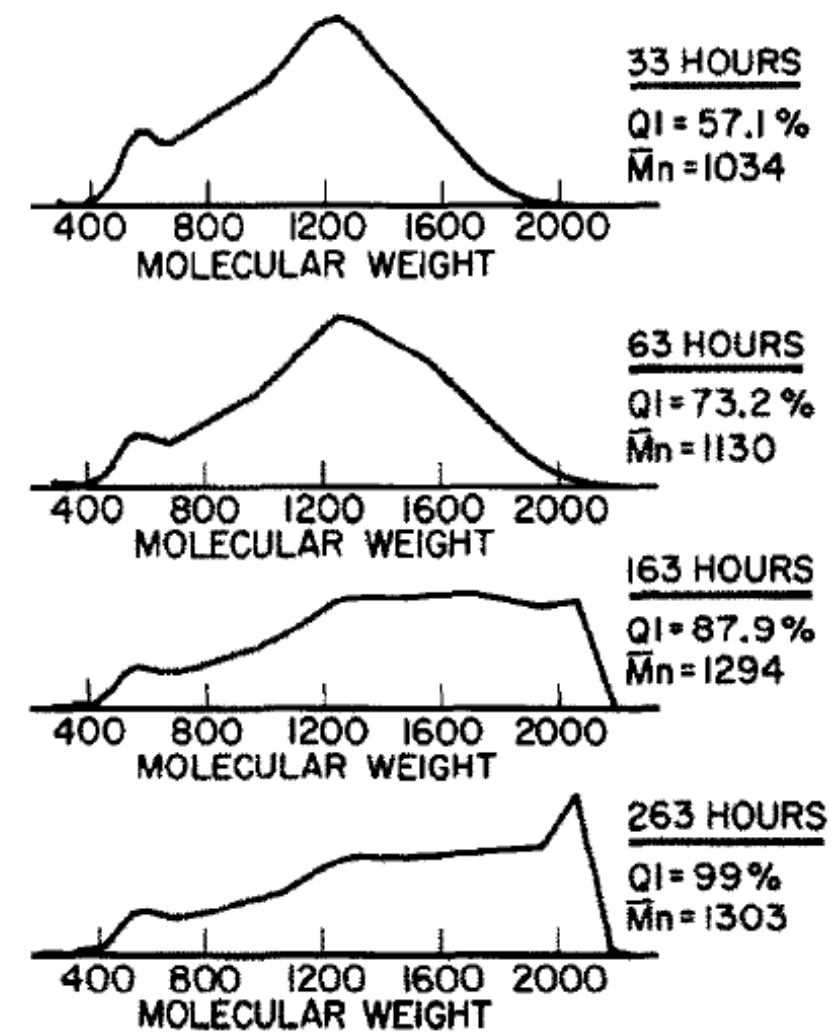
Figure 3. Molecular weight distribution of pitch during semi-coke formation; permitted from ref. [47].